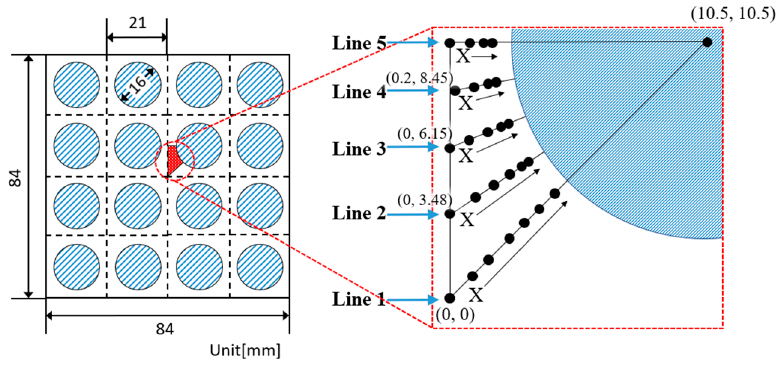
Figure 2. Measured points on Lines 1–5 for numerical analysis.